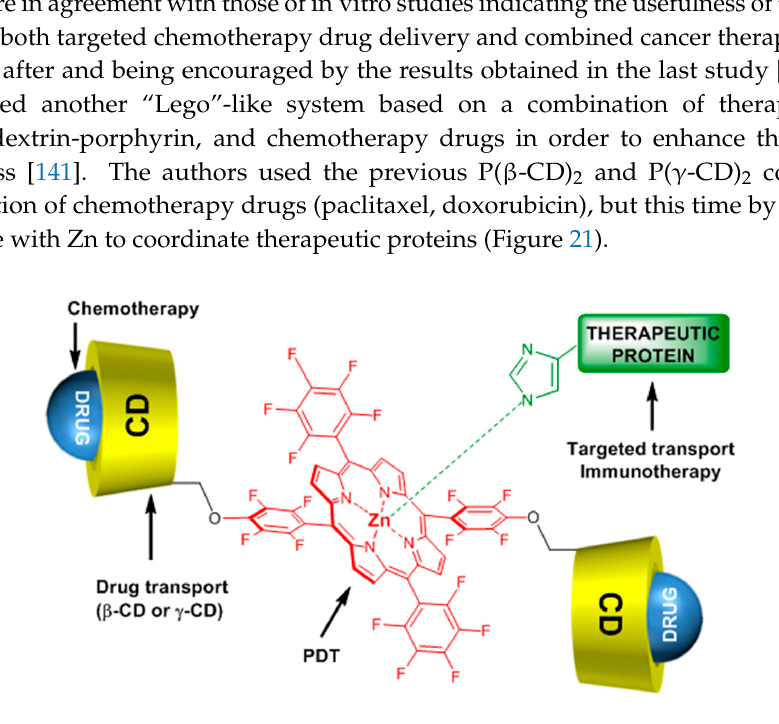
Figure 22. Effect of combined therapy with ZnP( β -CD) 2 or ZnP( γ -CD) 2 conjugates, chemotherapy drugs (paclitaxel or doxorubicin), and endoglobulin on the tumor volume of human amelanotic